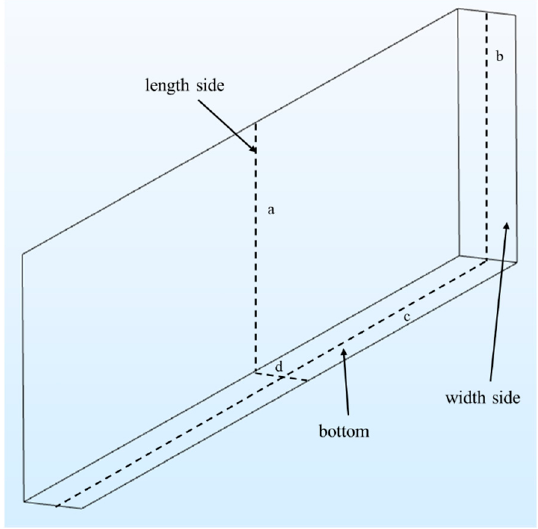
Figure 7. Current density distribution of the volumetric crack inner surface.